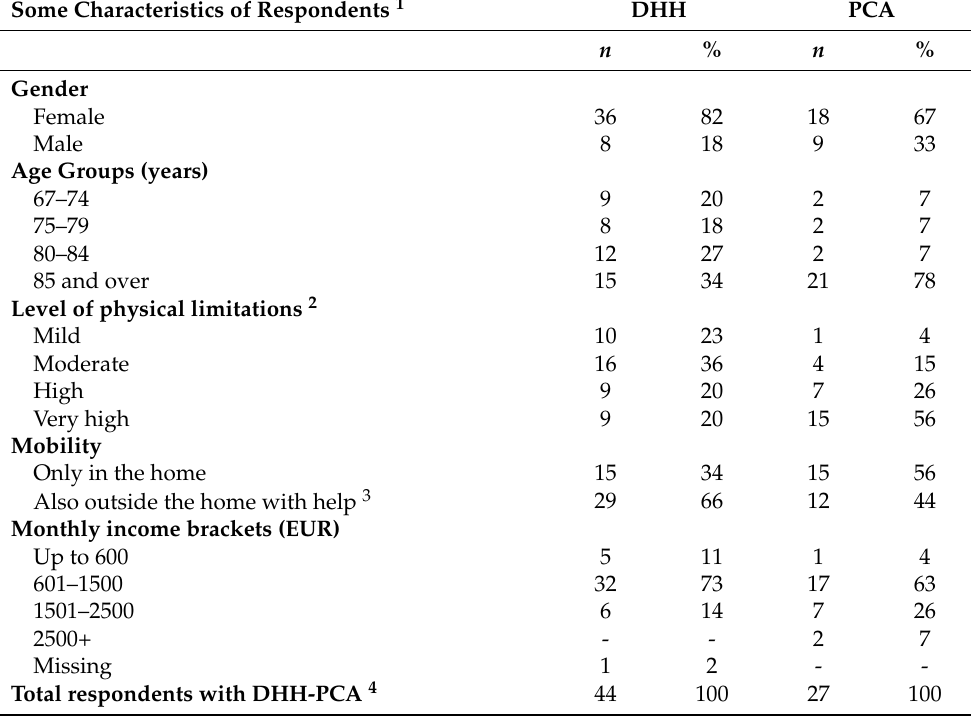
Table 7. Personal Care Assistant (PCA), Domestic Home Help (DHH), and older